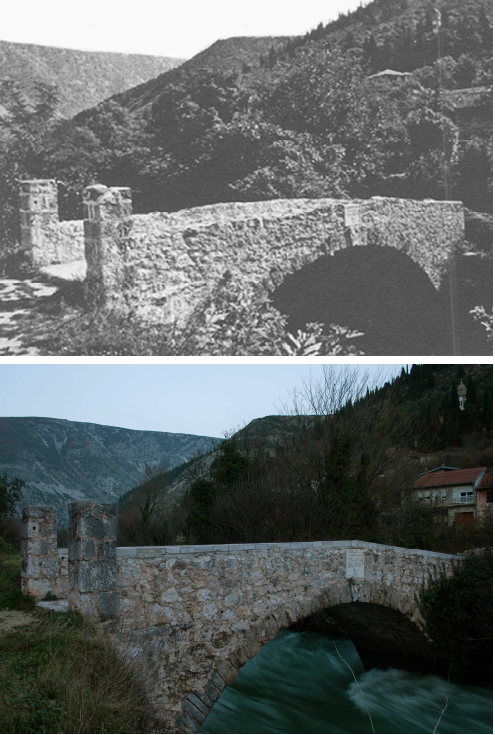
Figure 8 Ć uprija Sare Kašikovi ć - č asopis Most Bridge in Stolac at the beginning of the 20th century and the bridge photographed by participants during the